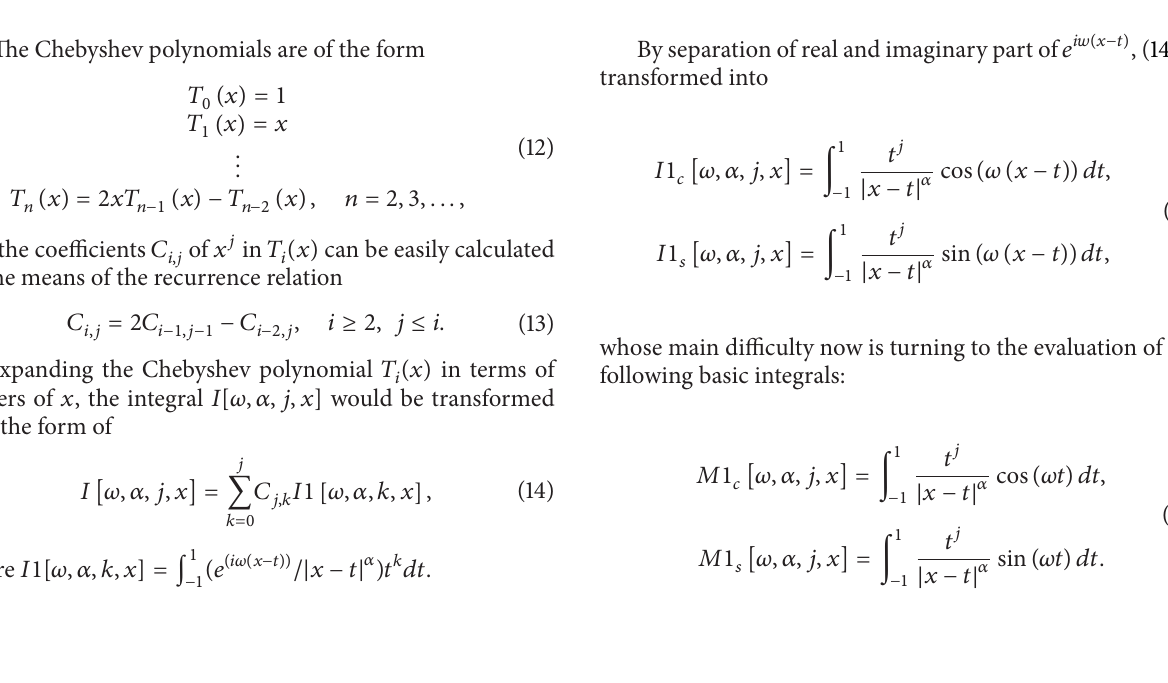
Figure 1: Example 1: the absolute error versus the 𝑥 -coordinate for 𝑁 = 4 (a), 𝑁 = 8 (b), and 𝑁 = 16 (c) with negative data ignored.